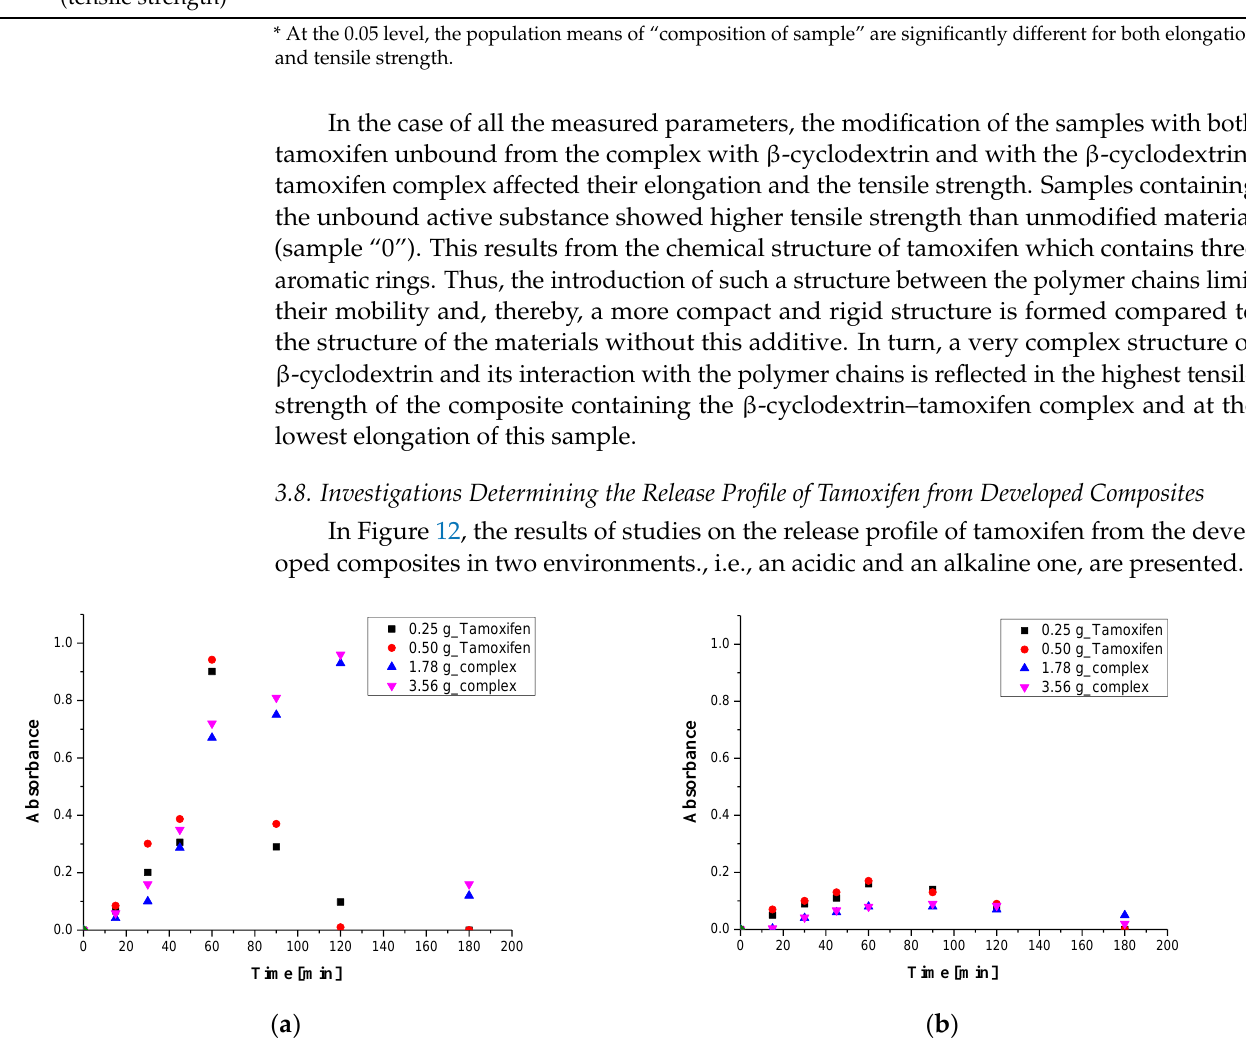
Table 6. Statistical analysis of obtained data based on the one-way analysis of variance (ANOVA) with repetitions.